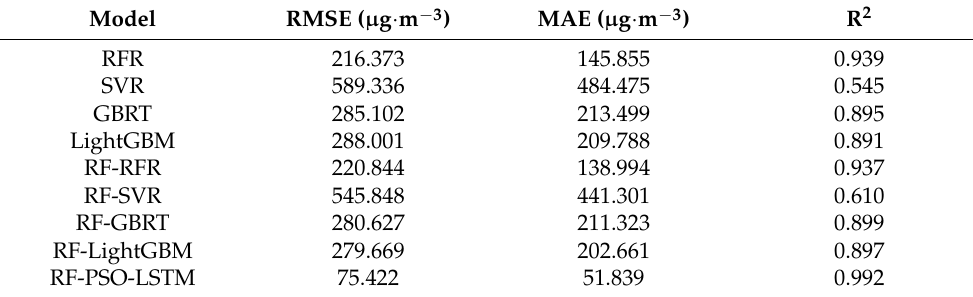
Table 8. Comparison of prediction performance of different